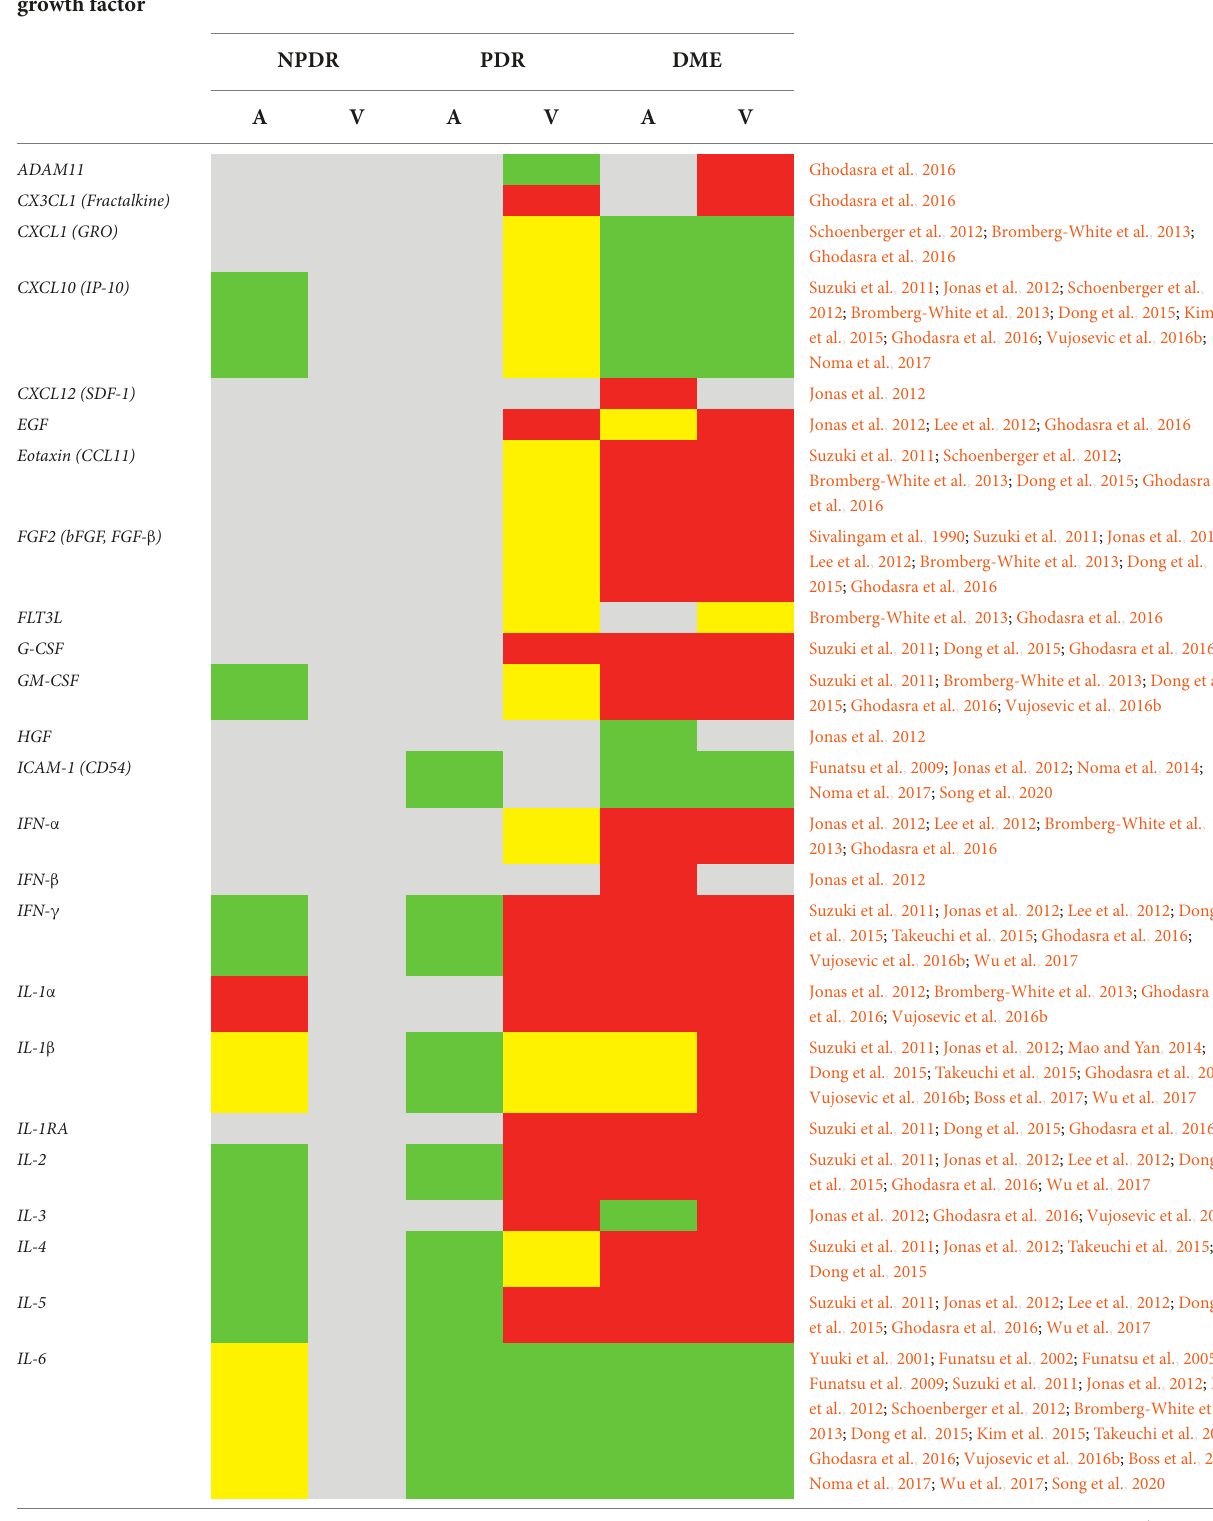
TABLE 1 Summary of inflammation-related cytokines, chemokines, and growth factors investigated in the aqueous humor (A) or vitreous (V) of human patients with non-proliferative diabetic retinopathy (NPDR), proliferative diabetic retinopathy (PDR), and diabetic macular edema (DME). Cytokine, Diabetic retinopathy chemokine, growth factor